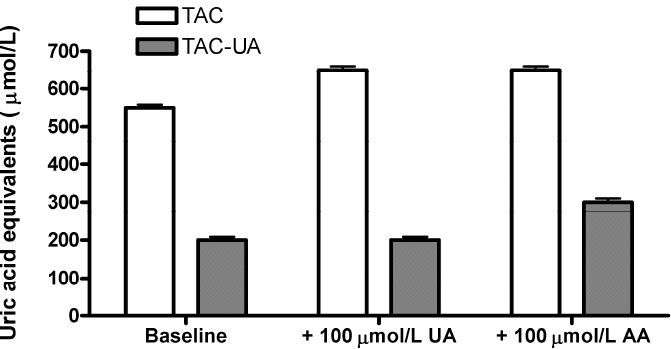
Figure 2. Determination of total and uric acid-independent antioxidant capacity (TAC and TAC-UA, respectively) for a regular sample (baseline), the sample with extra 100 μ mol/L of uric acid (UA) and the sample with extra 100 μ mol/L of ascorbic acid (AA). All data are expressed as means ± SD. All measurements for each sample were done in